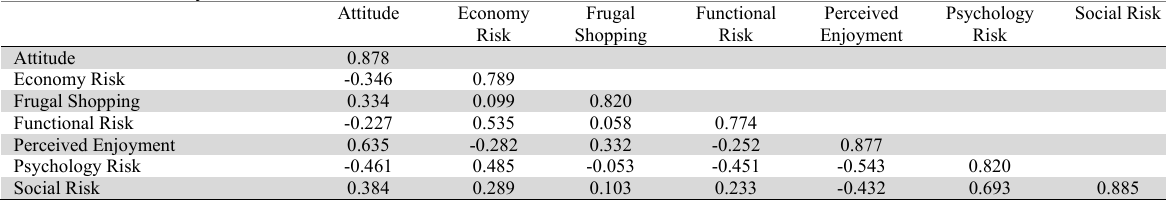
Discriminant Validity Non Renters